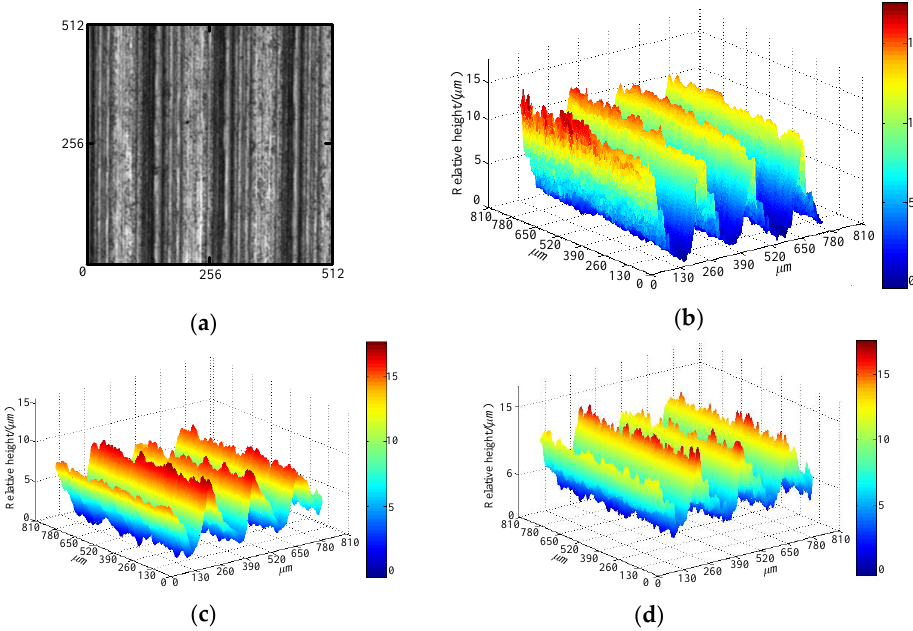
Figure 11. Experimental results for turning surface image: ( a ) Turning surface image; ( b ) Measured result; ( c ) Reconstruction result of Horn and Brooks algorithm; and ( d ) Reconstruction result of proposed algorithm.